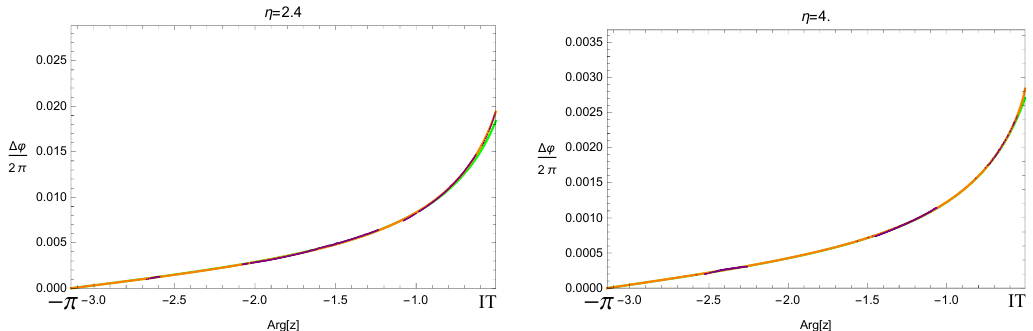
Figure 18. The non-CDD part of the elastic scattering phase ∆ ϕ as a function of arg( z ) . The orange curve is obtained by fitting the phase of (2.25). The purple curve segments are obtained by subtracting the fitted known CDD factors from the elastic scattering phase (spectral sets (3.13) computed from TFFSA over suitable ranges of cylinder radii, extrapolated to infinite truncation level). In the η = 2 . 4 case, the leading perturbative result for the non-CDD part, based on the 2 → 3 probability (4.4) is shown in green curve. In the η = 4 case, the perturbative result (green curve) is indistinguishable from the orange